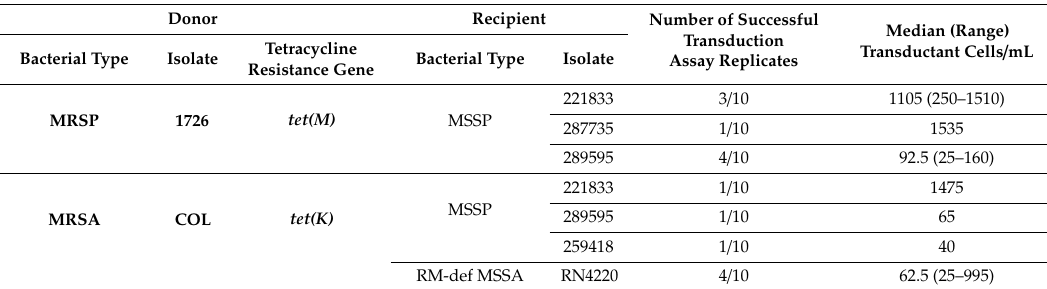
Table 2. Number of transductant cells / mL following successful transduction assays for tet(M) and tet(K) . Cell numbers are derived from colony counts following transduction assays incubated at 37 ◦ C for 48 h on LK agar containing 30 mg / L tetracycline.